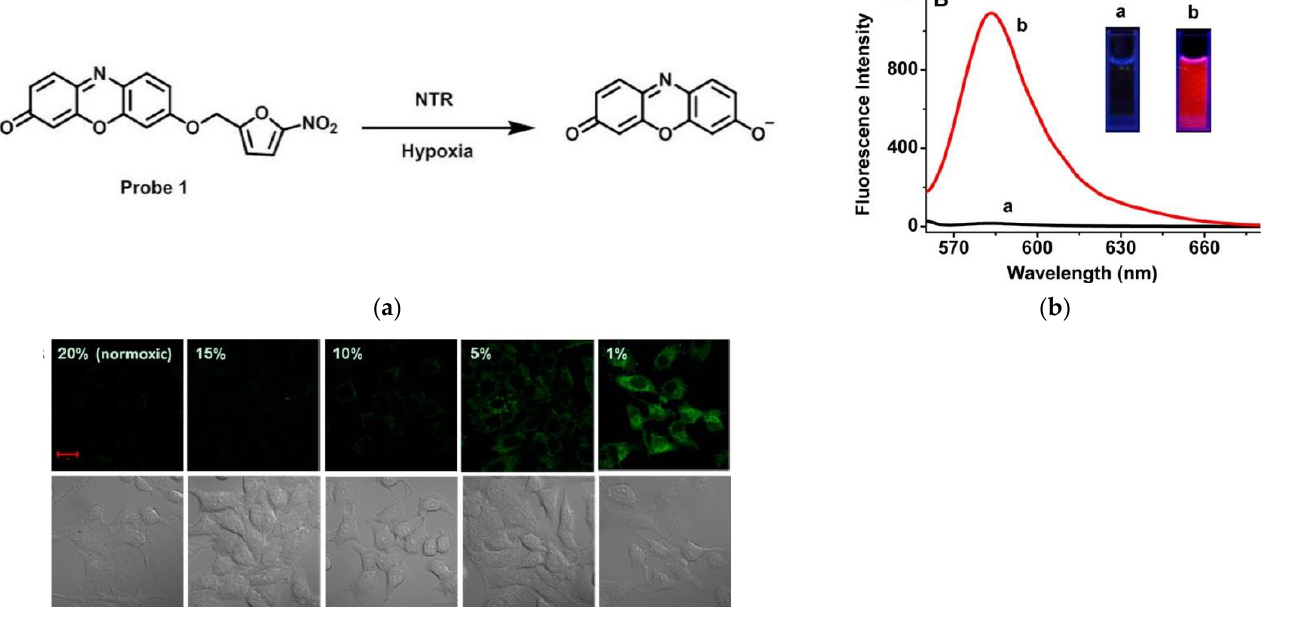
Figure 7. ( a ) Detection mechanism of probe 1 for NTR; ( b ) Fluorescence emission spectra of probe 1 ( b-a ) before and ( b-b ) after reaction with NTR; ( c ) Confocal fluorescence images of Hela cells under different oxygen conditions. Reproduced with permission from [59]. Copyright 2013 American Chemical Society.